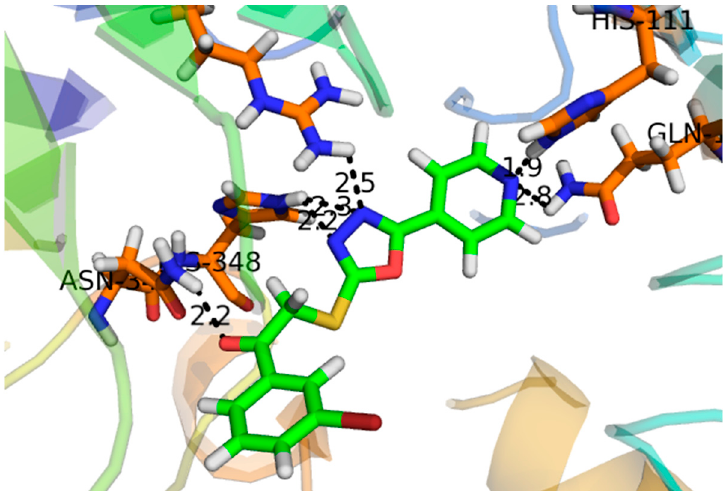
Figure 5. Represent the 3D structures of Compound 3 showing binding potential. Red color in the image shows position of oxygen, green benzene ring, white hydrogen atom, brown color indicates amino acid sequence and blue color indicate nitrogen or amino group.